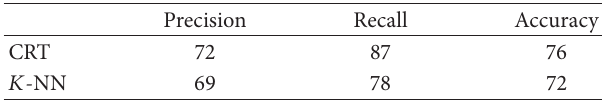
Table 3: Pearson correlations between SemSyn and the measures of the linguistic compounds. FAM AoA TRANS IMG SemSyn − .397 .439 − .400 − . 483